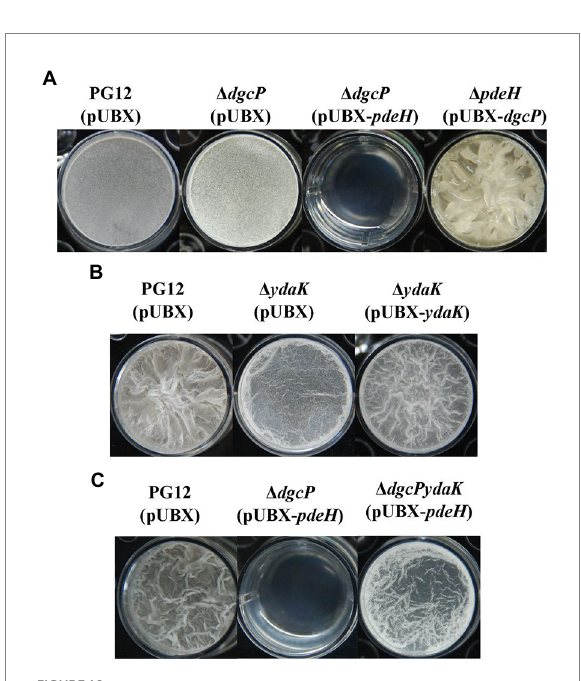
FIGURE 10 Biofilm formation of B. velezensis PG12(pUBX) and its derivatives. B. velezensis cells were grown in LB broth at 37 ° C overnight and then transferred to fresh LB broth to grow to mid-log phase (OD 600 0.8–1.0). 2 μ l of the cultures mixed with 2 ml of MSgg broth supplemented with 1% xylose solution at the final concentration were transferred to the wells of 24-well microtiter plates. The plates were incubated at 28 ° C. Images were taken using a Nikon BM-7 digital camera after 48–72 h. (A) Microtiter plate assay of biofilm formation by B. velezensis PG12(pUBX)